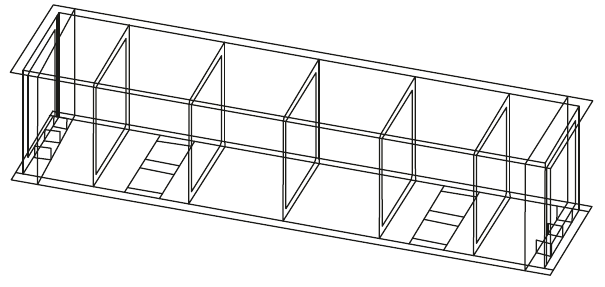
Figure 2: The model of the wide girder.